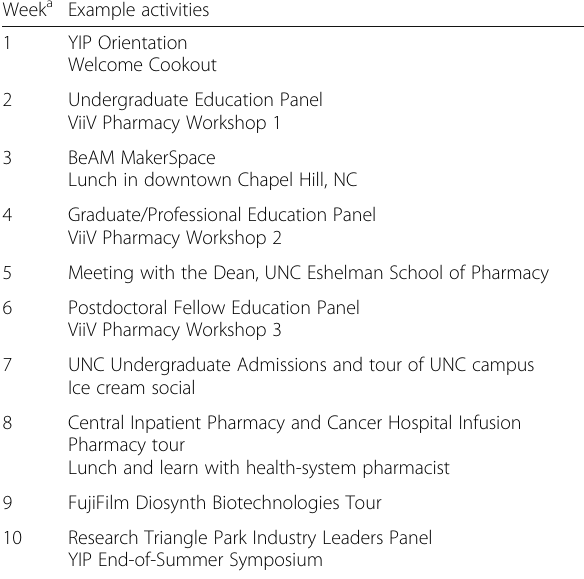
Table 1 Weekly schedule for interns in the 2016